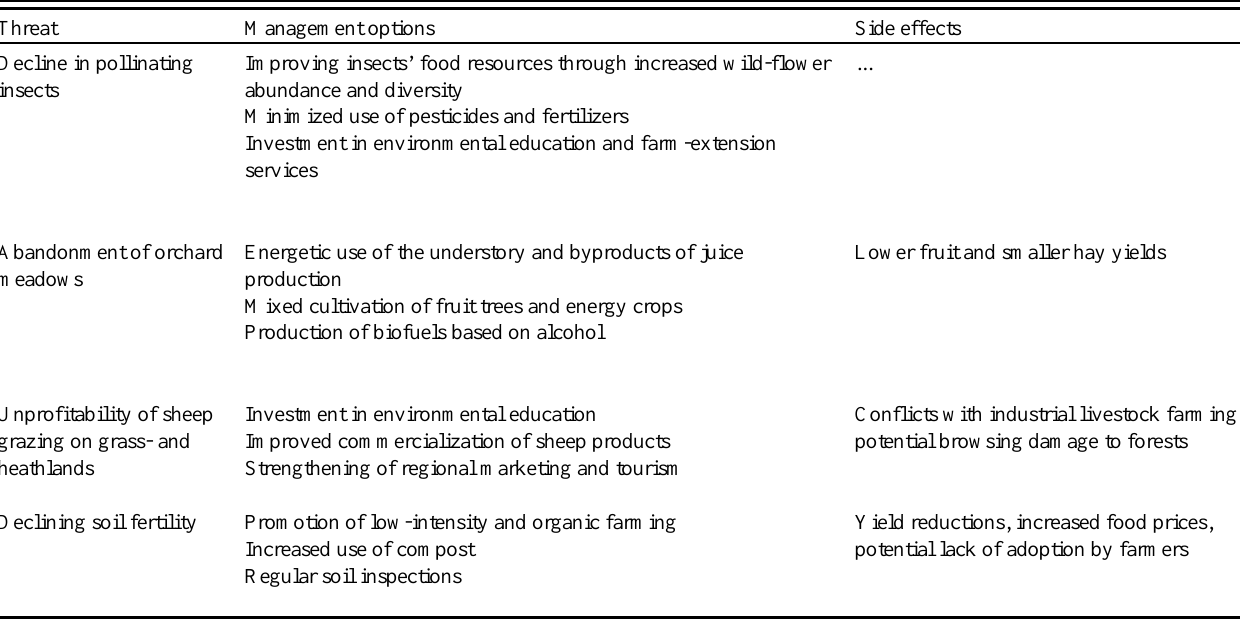
Table 3 . Management options to particular threats and potential side effects, as proposed by local